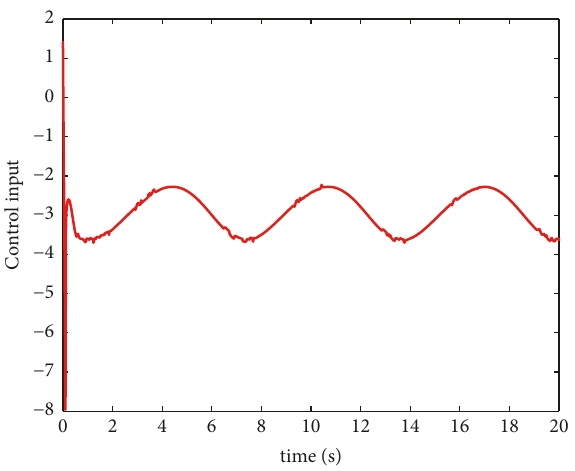
Figure 10: The tracking errors of NNSMC with 𝑥 𝑑 = 0.1 sin (𝑥) .